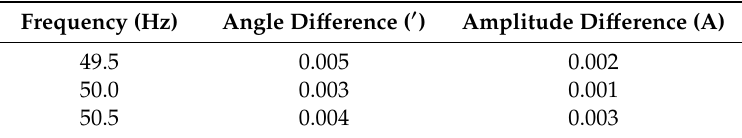
Table 3. Di ff erence between two channel signals at di ff erent Table 3. Difference between two channel signals at different frequencies.